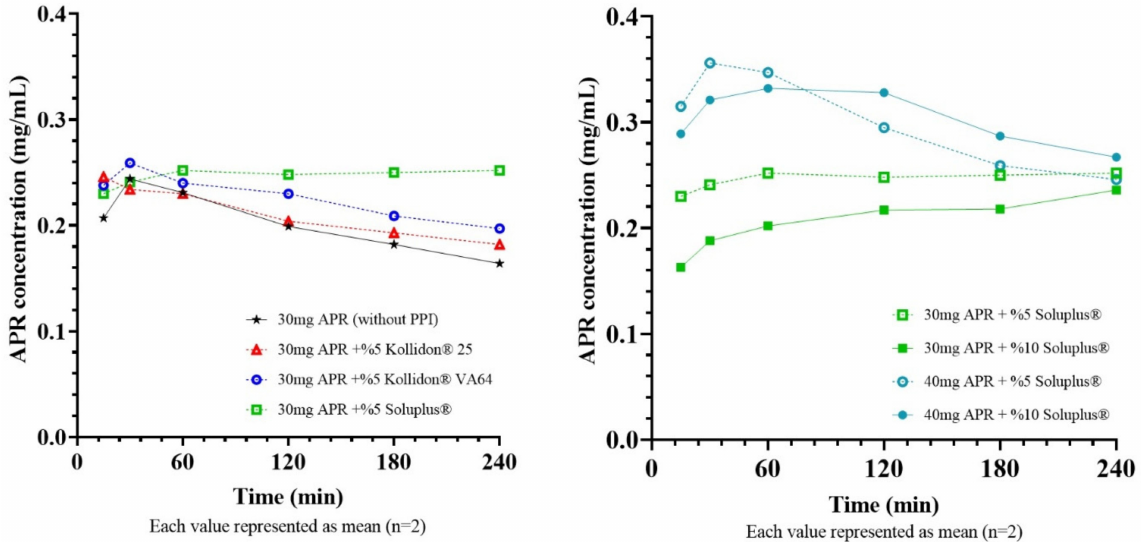
Figure 10. Concentration-time curves of super-SNEDDS